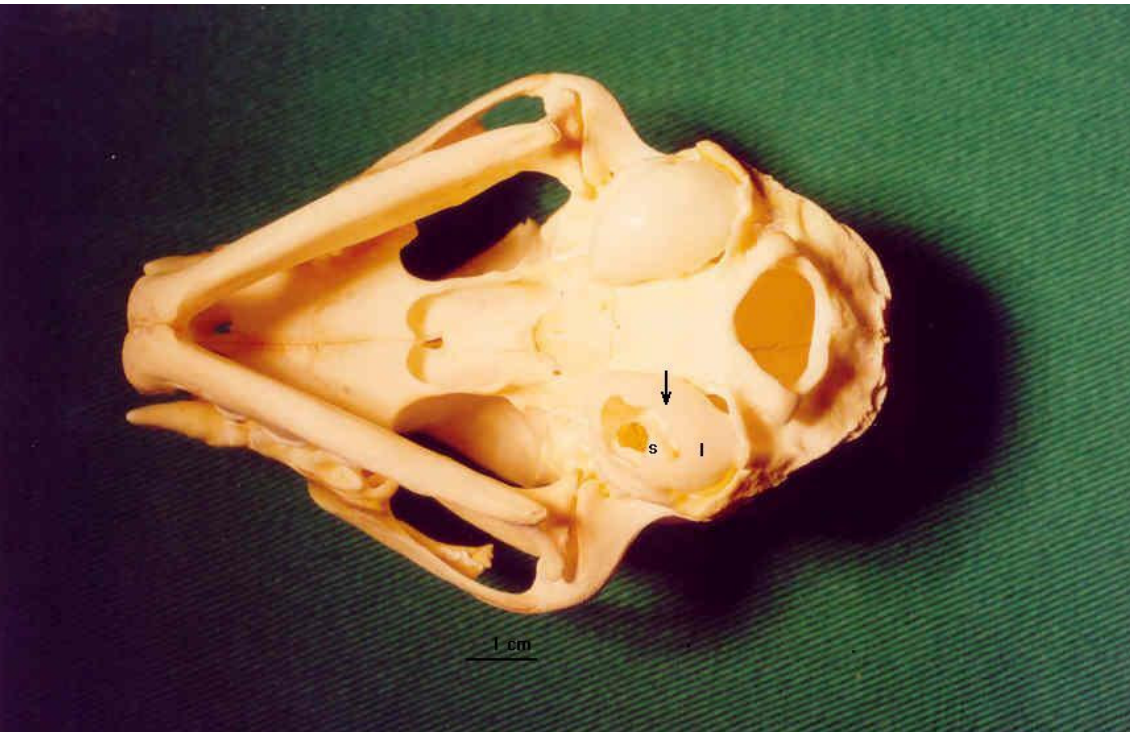
FIGURE 1 - Photograph of a feline skull, showing ventral tympanic bulla osteotomy (arrow). Observe the larger compartment (l) and the smaller compartment